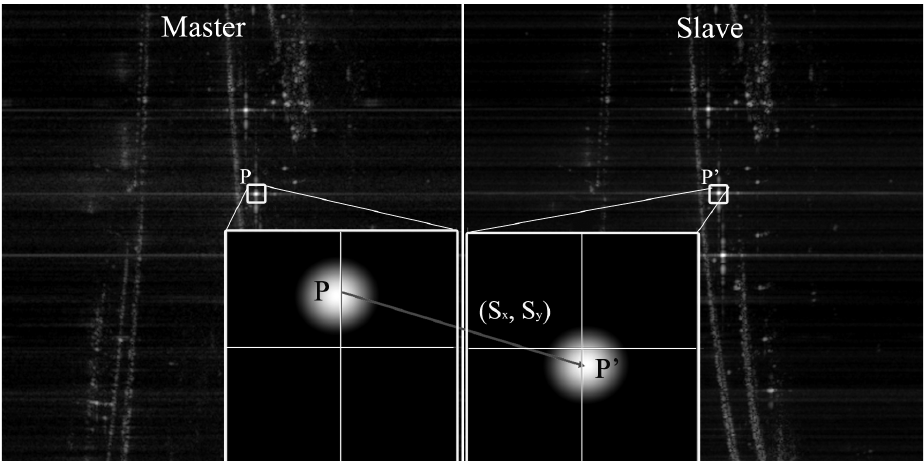
Fig. 1. Two GB-SAR amplitude images, master and slave, collected over the same place. The same point is identified in both images, P and P’, and then the displacement vector ( S x , S y ) is estimated at sub-pixel level as shown in the small frames.